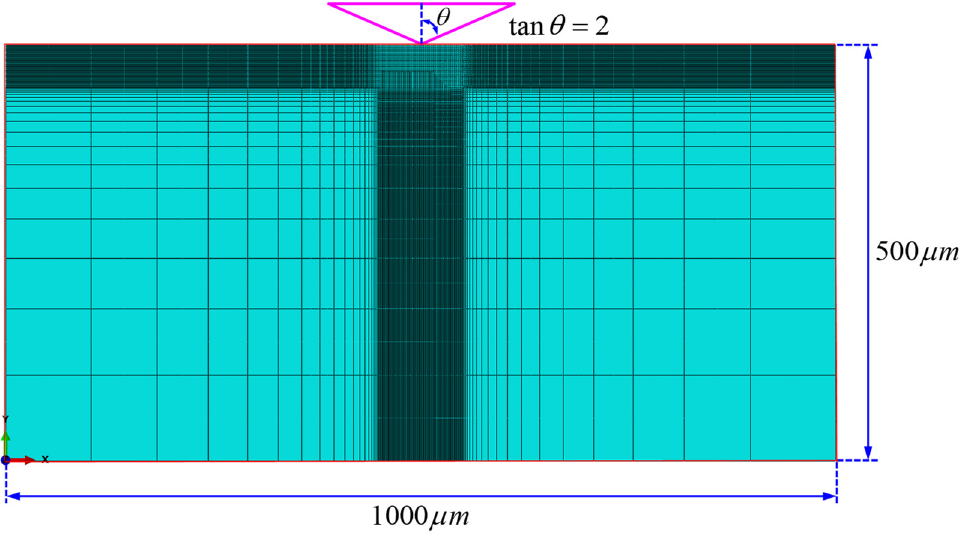
Figure 5. Schematic of meshing and assembly between indenter and sample.